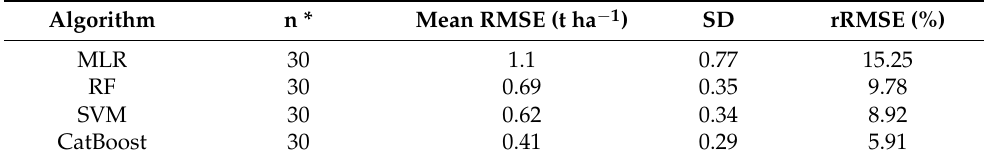
Table 2. Mean values of RMSE, SD and rRMSE of the four algorithms (MLR, Multiple Linear Model; RF, Random Forest; SVM, Support Vector Machine; CatBoost). Three different datasets were employed: S1 using only data from S1, S2 using data only from S2 and S1S2 using data from S1 and S2.